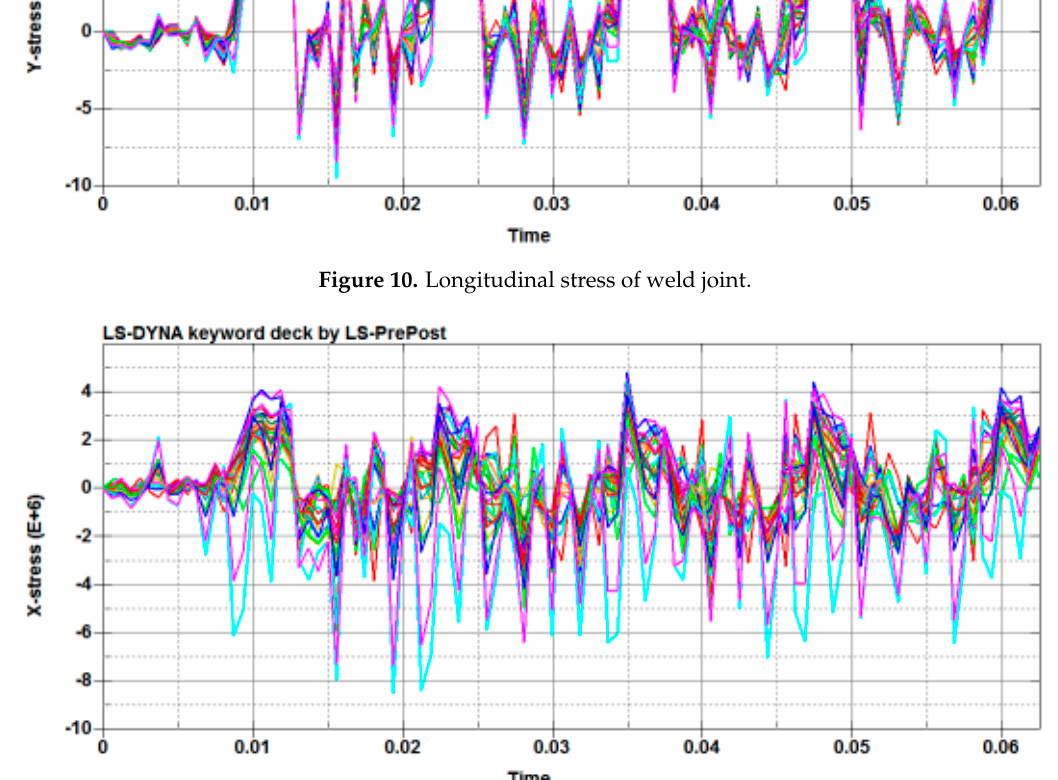
Figure 11. Transverse stress of weld joint.